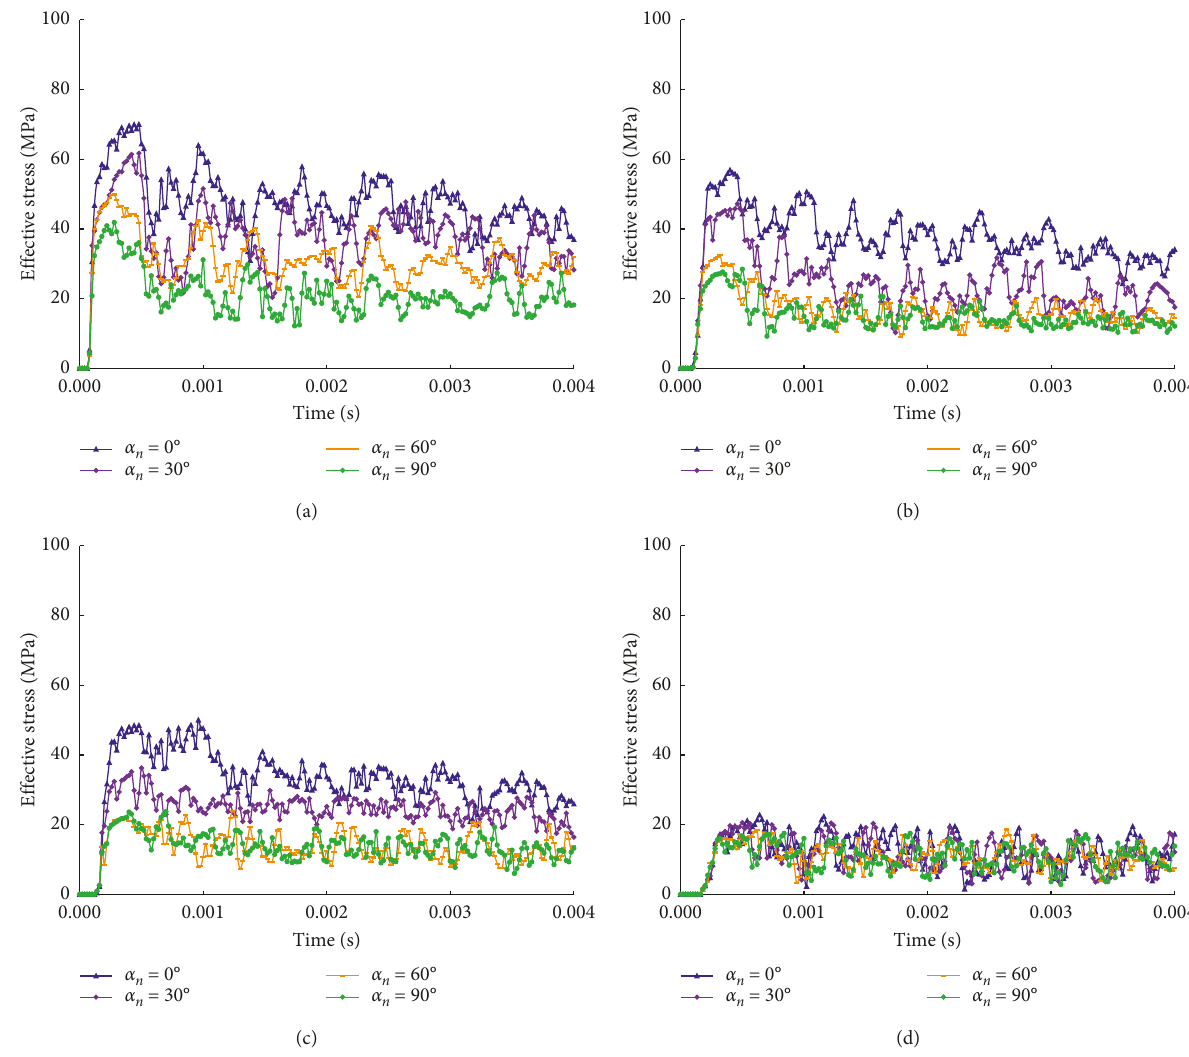
Figure 17: Effective stress curve of different monitoring points of #2 simulation case. (a) D r b �